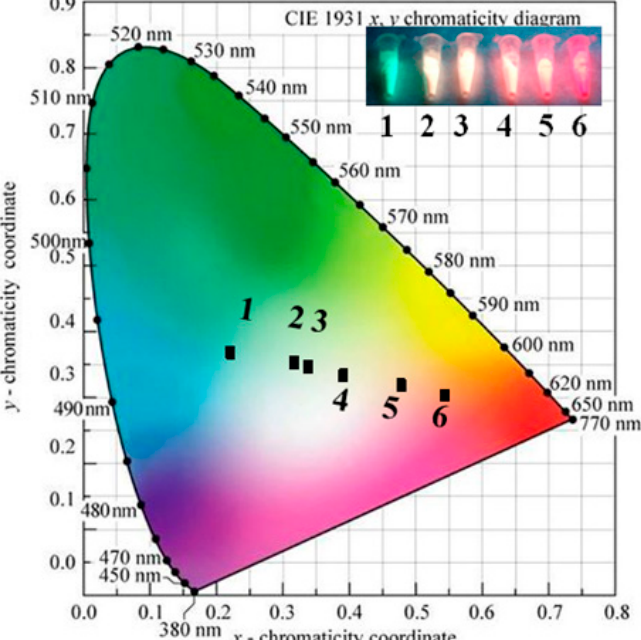
Figure 6. Commission Internationale de l’Éclairage’s (CIE) chromaticity diagram of CGP:0.006Eu 2+ , x Mn 2+ phosphors under 380 nm excitation: (1) x = 0; (2) x = 0.015; (3) x = 0.02; (4) x = 0.03; (5) x = 0.07; (6) x = 0.1. The insets show CGP:0.006Eu 2+ , x Mn 2+ phosphors irradiated under 365 nm UV light in a lamp box.